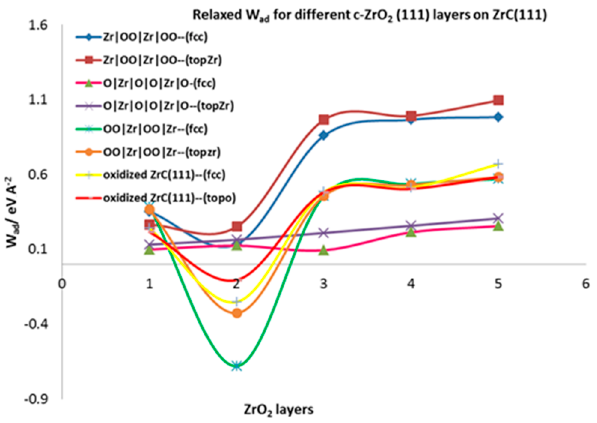
Figure 6 . Relaxed Work of adhesion for different interface models of c ‐ ZrO 2 (111) on ZrC(111) Figure 6. Relaxed Work of adhesion for different interface models of c -ZrO 2 (111) on ZrC(111) surface. surface.